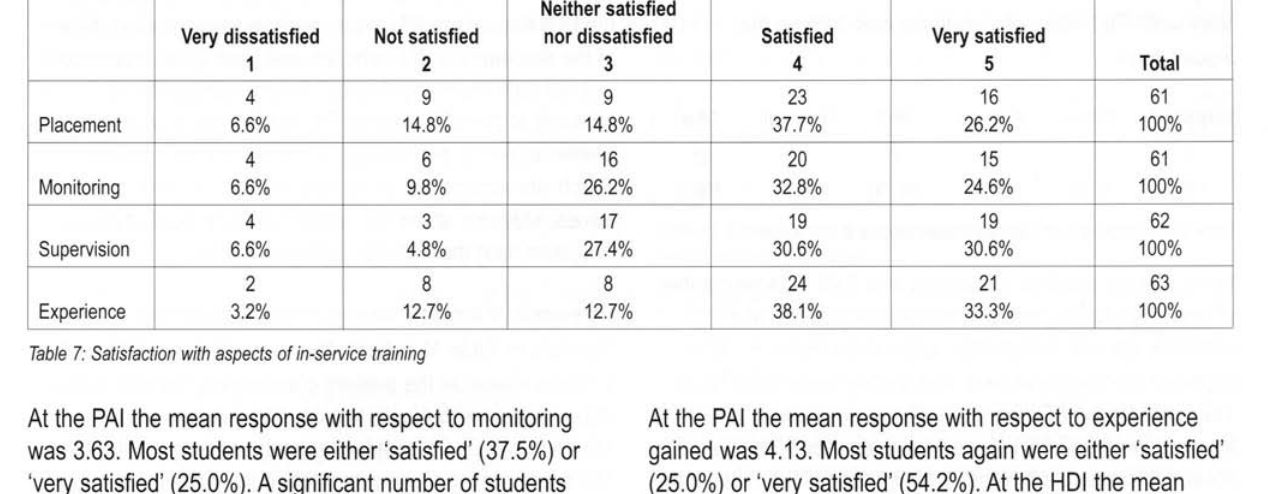
Table 7: Satisfaction with aspects of in-service training At the PAl the mean response with respect to monitoring was 3.63. Most students were either 'satisfied' (37.5%) or